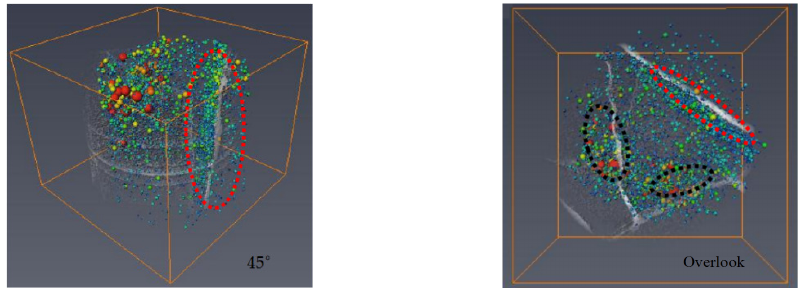
Figure 12. Relationship between final failure cracks and quartz particle distribution.